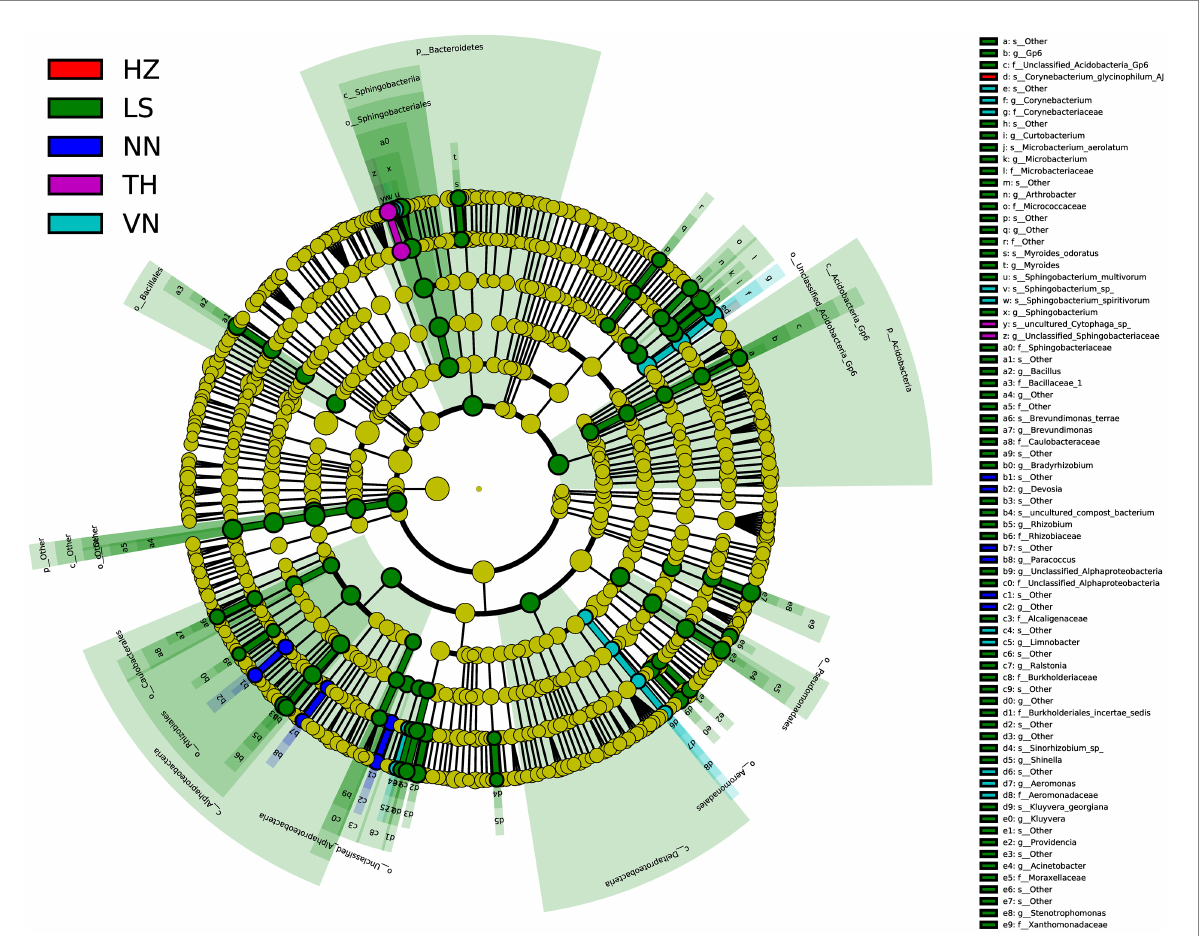
FIGURE 6 Cladogram of bacterial biomarkers, from the phylum (innermost ring) to species (outermost ring) level, with an LDA score > 2. Differential bacterial taxa are marked by lowercase letters. Each small circle at different taxonomic levels represents a taxon at that level, and the diameter of the circle is proportional to the relative abundance. The coloring principle is to color the taxa with no significant difference as yellow and the other different taxa as the group with the highest abundance of the species. Different colors represent different groups, and nodes with different colors represent the communities that play an important role in the group represented by the